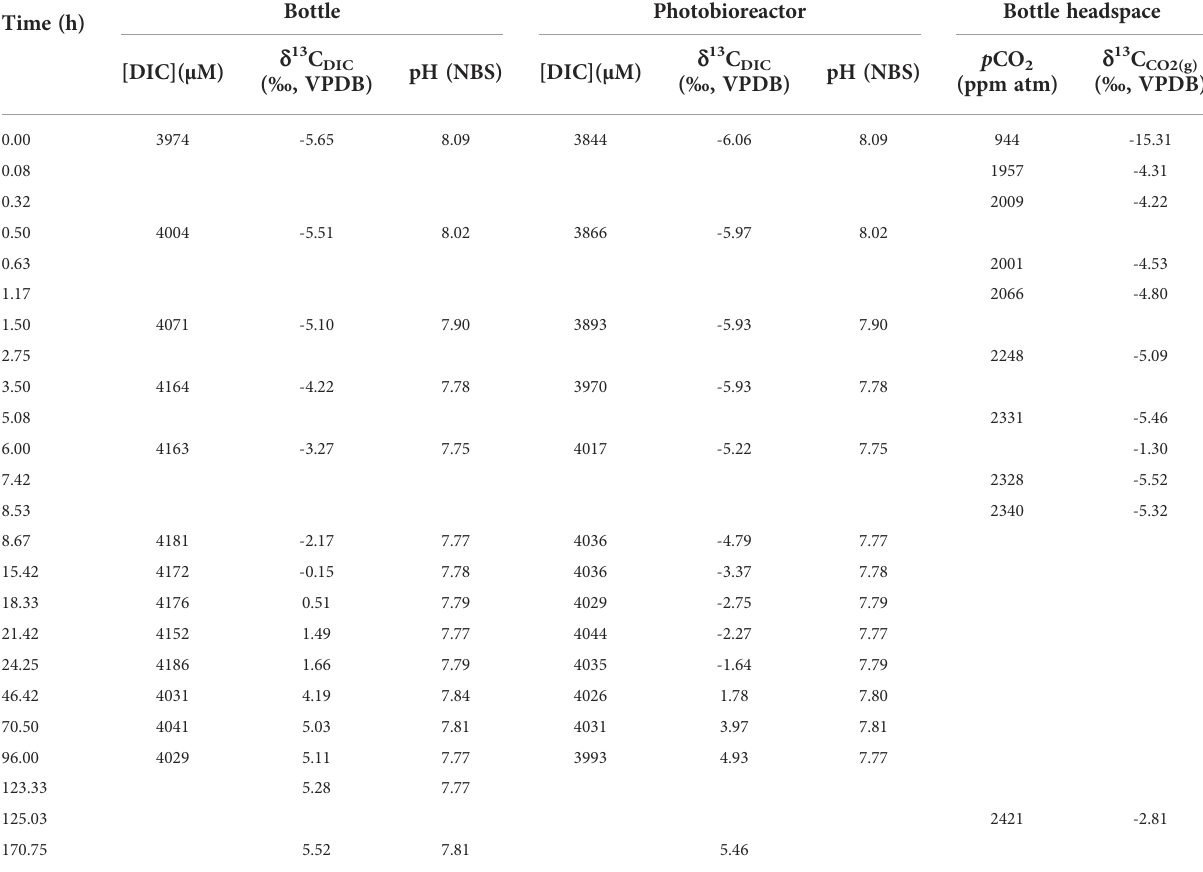
TABLE 3 DIC and CO 2 (g) in headspace measurements during large system bubbling. Bottle Photobioreactor Bottle Time (h)